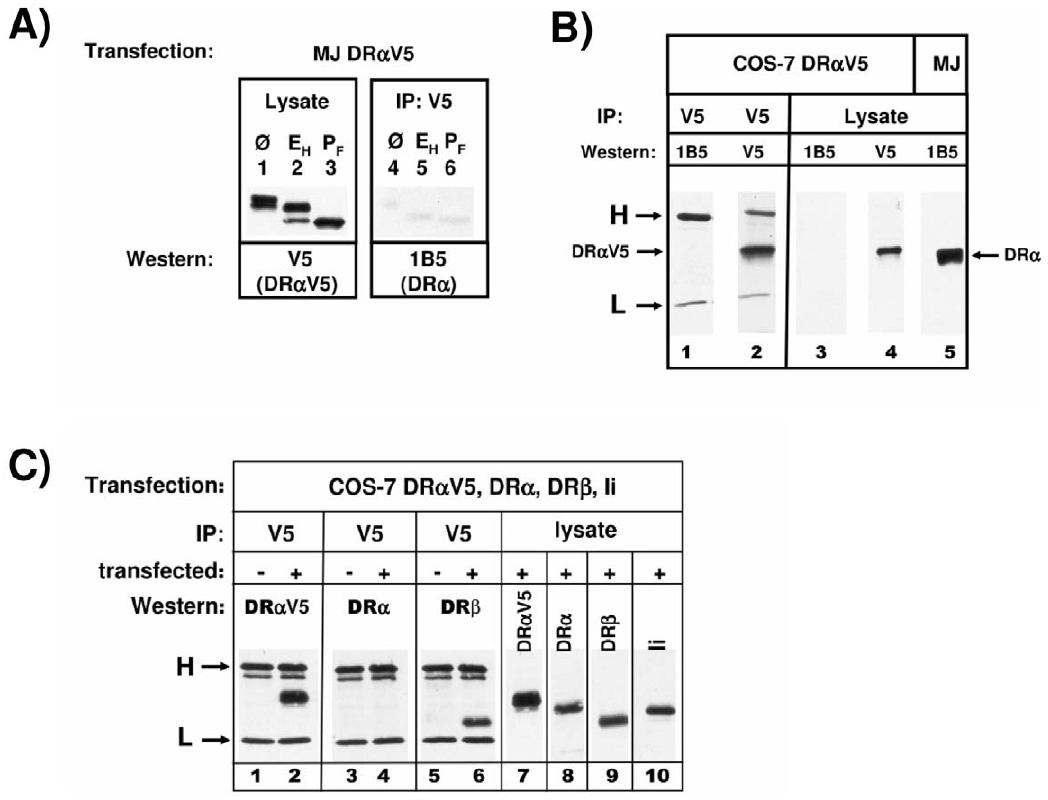
Figure 6. Isolation of Ab-epitope tagged DR a chains from transfected MelJuSo cells. A) MelJuSo cells transfected with DR a V5 cDNA were lysed. Cell lysates and V5-immunoprecipitates from cell lysates were digested with EndoH (E H ) (lanes 2 and 5), with PNGse F (P F ) (lanes 3 and 6), or left untreated (Ø) (lanes 1 and 4). SDS-PAGE separated cell lysates were immunoblotted for DR a V5 (monoclonal antibody V5) and V5-immunoprecipitated for DR a (western blotted with DR a monoclonal antibody TAL-1B5). B) Reactivity of monoclonal antibody TAL-1B5 to V5-tagged DR a is abolished. COS-7 cells were transfected with DR a V5 encoding cDNA. Cell lysate was immunoprecipitated with V5 or with TAL-1B5 (DR a ) monoclonal antibodies. Immunoprecipitates were separated in lanes 1 to 4, and lane 5 contains lysate of MelJuSo cells. Lanes were western blotted as indicated. C) COS-7 cells were transfected with DR a V5, DR a , DR b and Ii encoding cDNAs. Cell lysates from transfected ( + ) and from non-transfected ( 2 ) COS cells were immunoprecipitated for V5 (lanes 1 to 6). Immunoprecipitates and cell lysates (lanes 7 to 10) were SDS-PAGE separated and western blotted with mAbs V5 for DR a V5, TAL-1B5 for DR a , LGII-612.14 for DR b , and Bu43 for Ii.